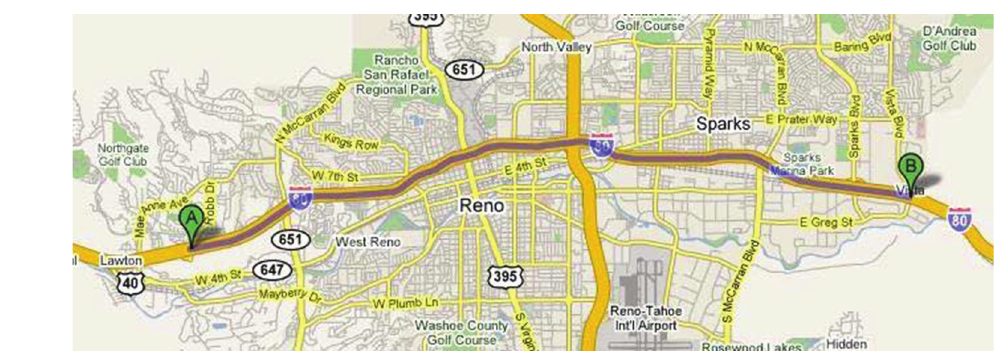
Figure 4: Map of Interstate 80 study sections. Table 3: Segment crashes and skid marks on Interstate 80